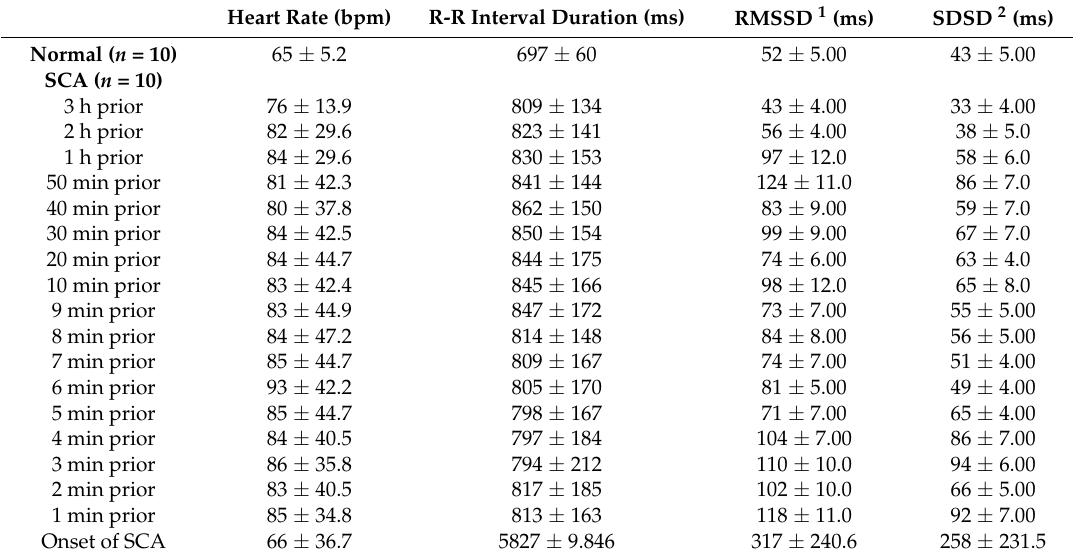
Table A1. Tabular summary of the extracted ECG features: mean resting heart rate, mean R-R interval duration, and heart rate variability features (RMSSD and SDSD) ( n = 20).